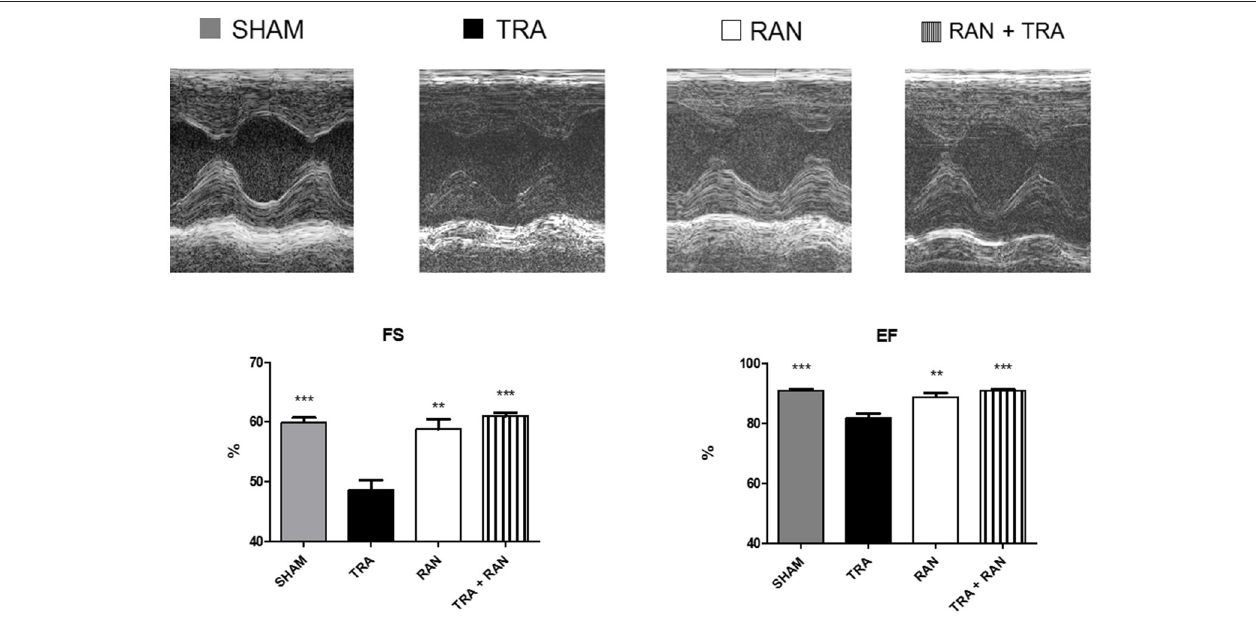
FIGURE 1 | Ranolazine protects from trastuzumab-related cardiac dysfunction. Ranolazine blunts reductions in fractional shortening (FS) and ejection fraction (EF) induced by trastuzumab (** p < 0.01 vs TRA; *** p < 0.001 vs TRA).